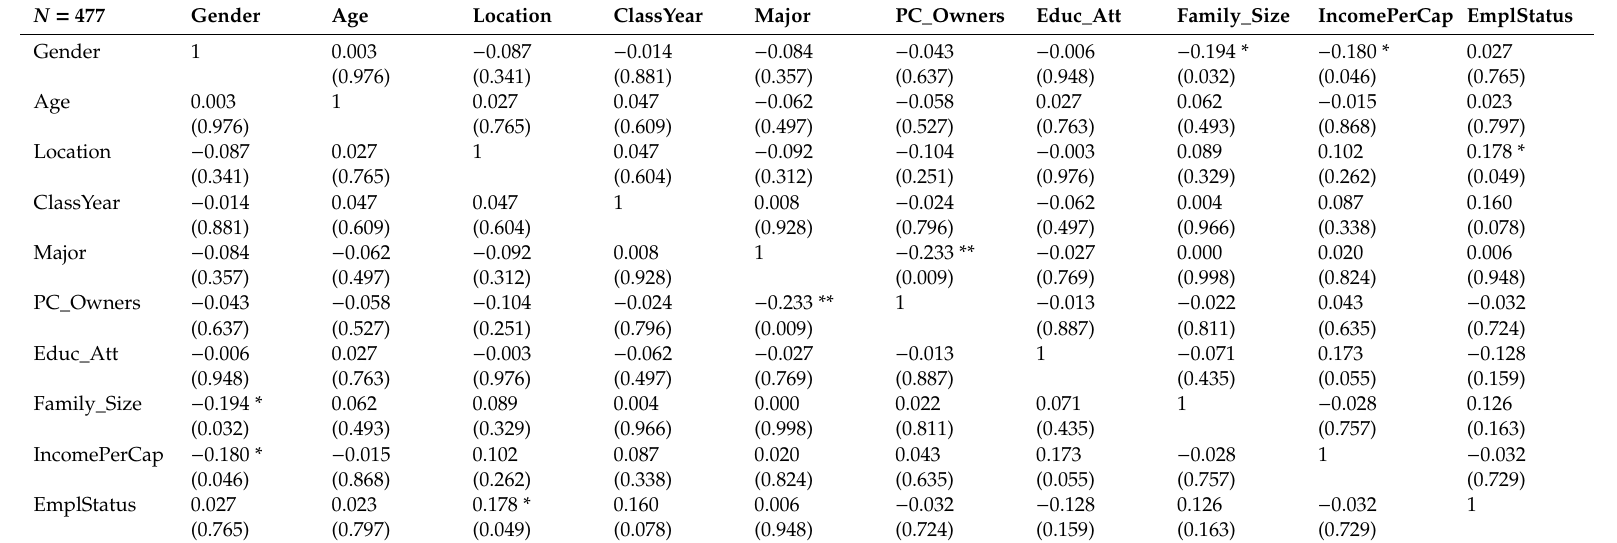
Table 3. Correlation between variables characteristics of Matrix M and W for the 1st